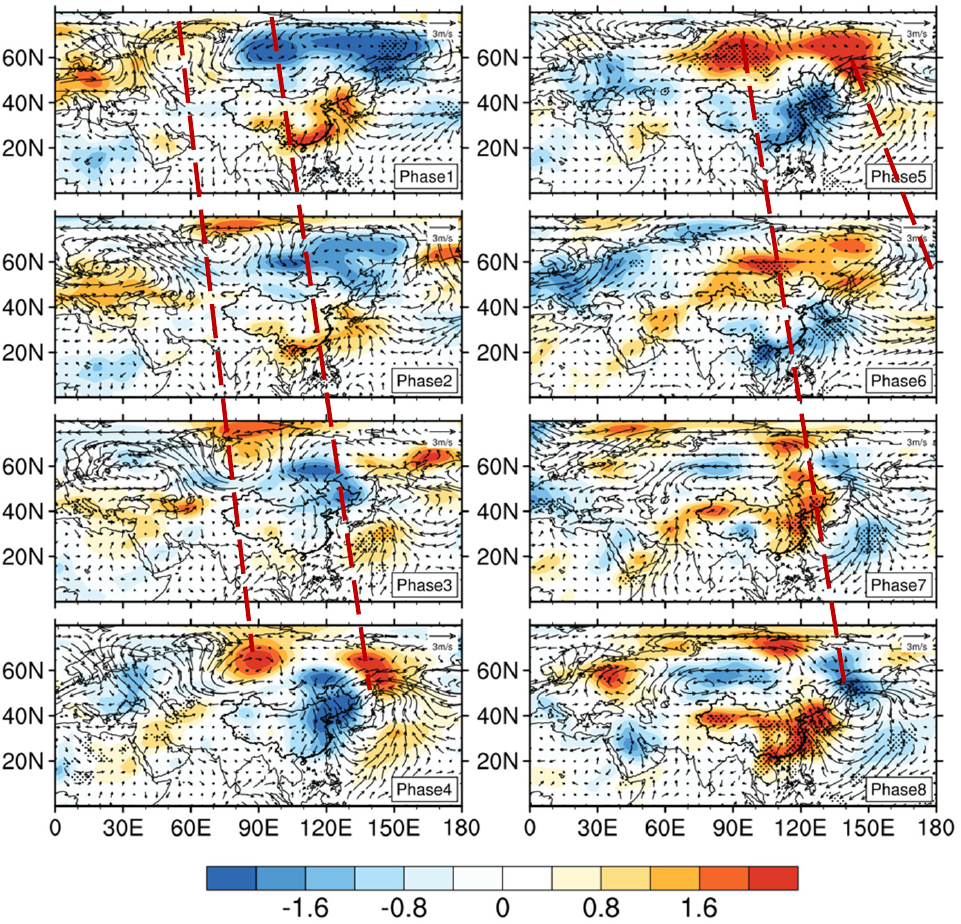
Figure 7. Temporal evolution of 10–30-d filtered 925-hPa temperature (shading, unit: °C) and wind (vector, unit: m · s − 1 ). (Dotted areas are where temperature passed 95% significance test; the red line is the cyclone and anticyclone.)